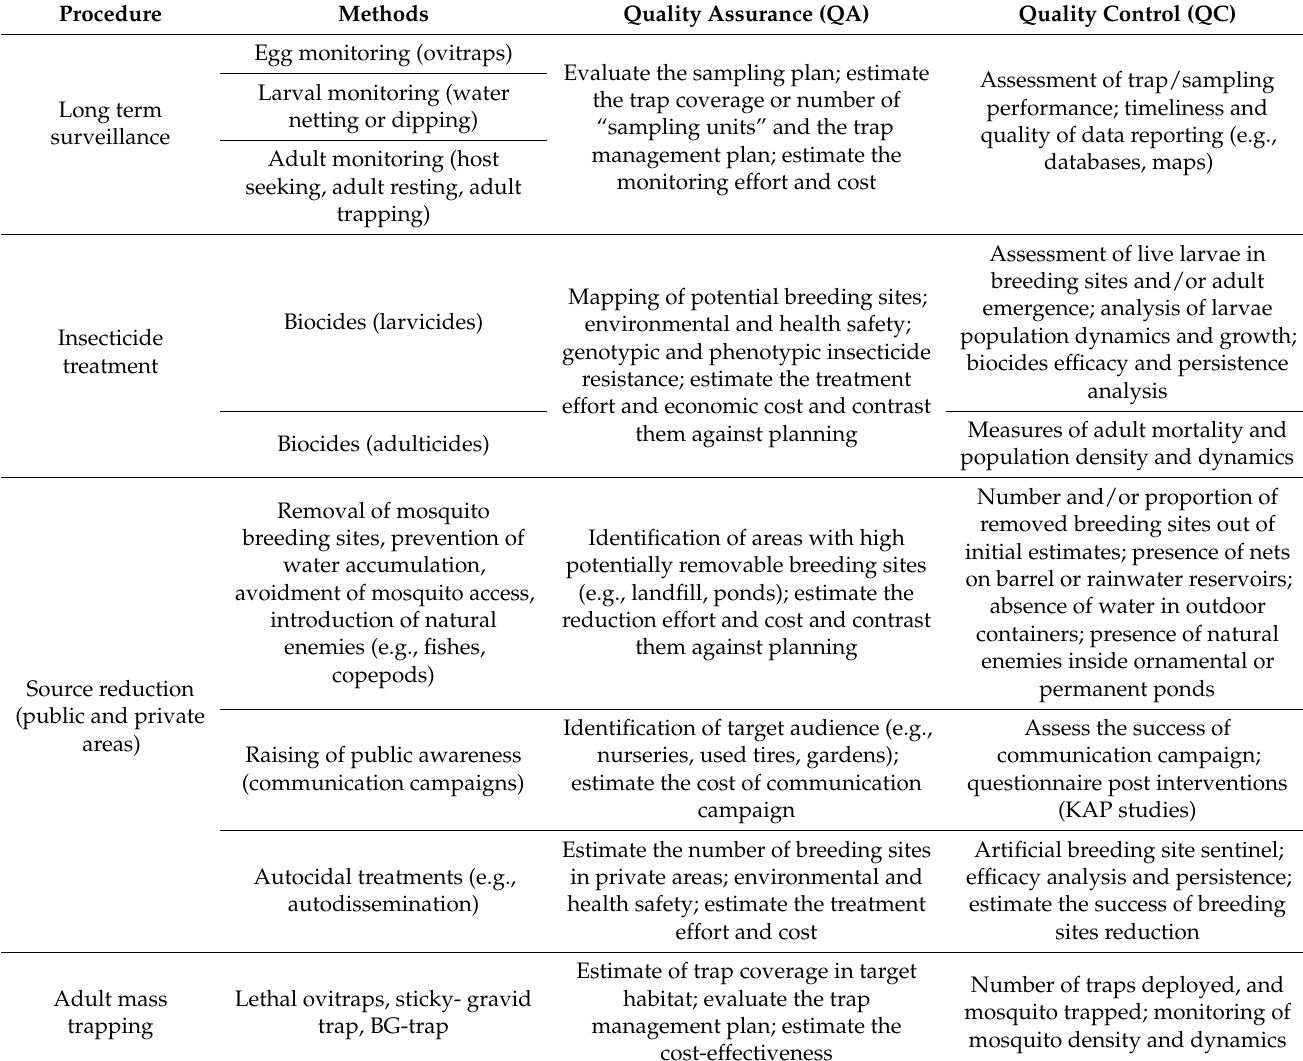
Table 1. Procedures, methods and indicators for quality assurance (QA) and quality control (QC) of mosquito surveillance and control programs in